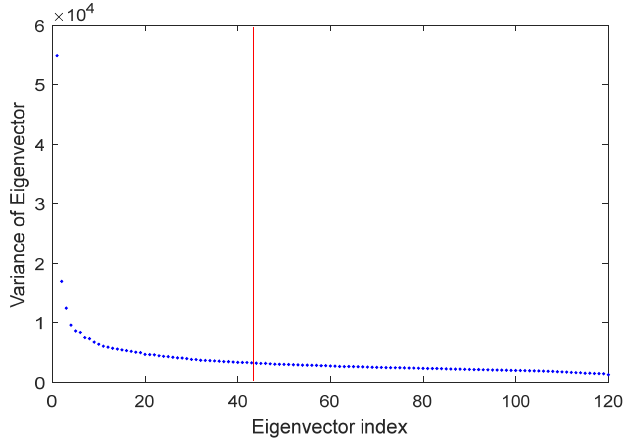
Figure 4. Determining the appropriate number of features in the SVD algorithm .